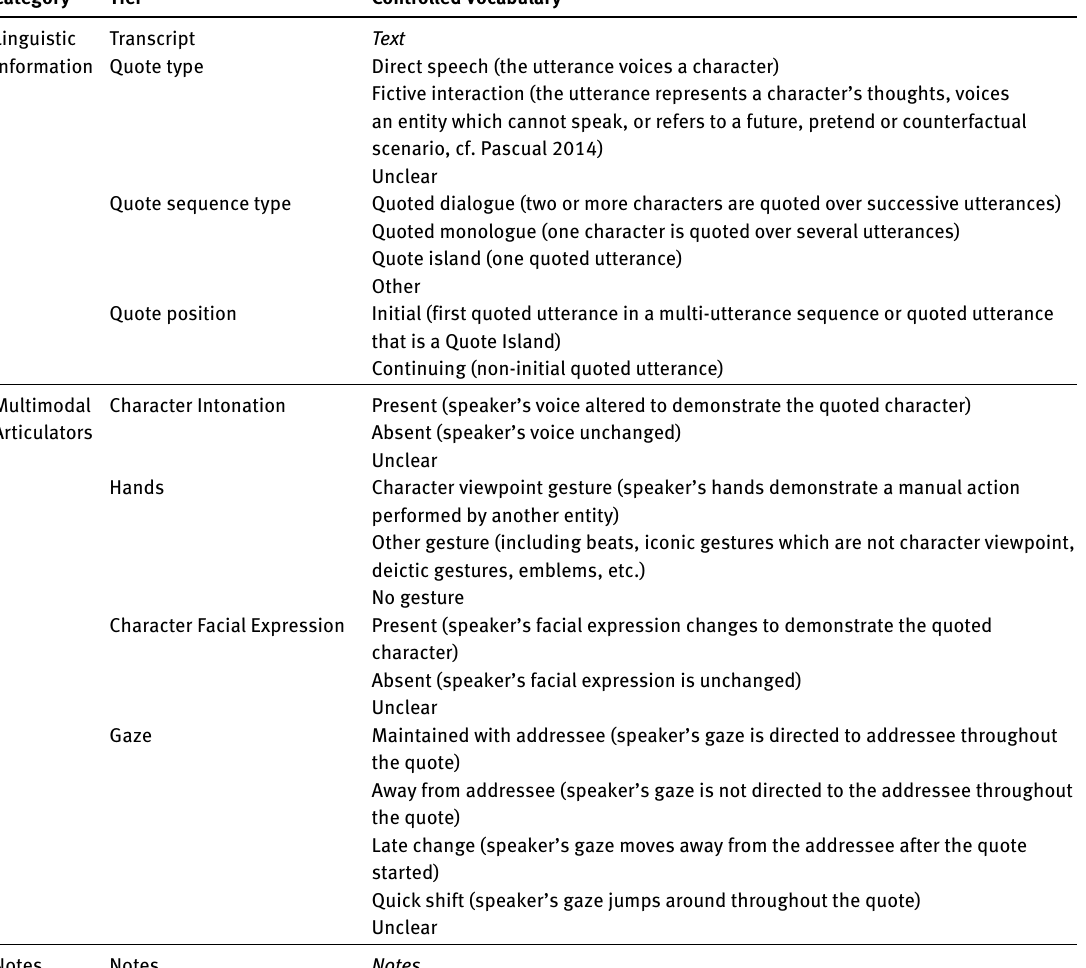
Table 1: ELAN tiers and controlled vocabularies used (adapted from Table 3 in Stec et al. 2015).